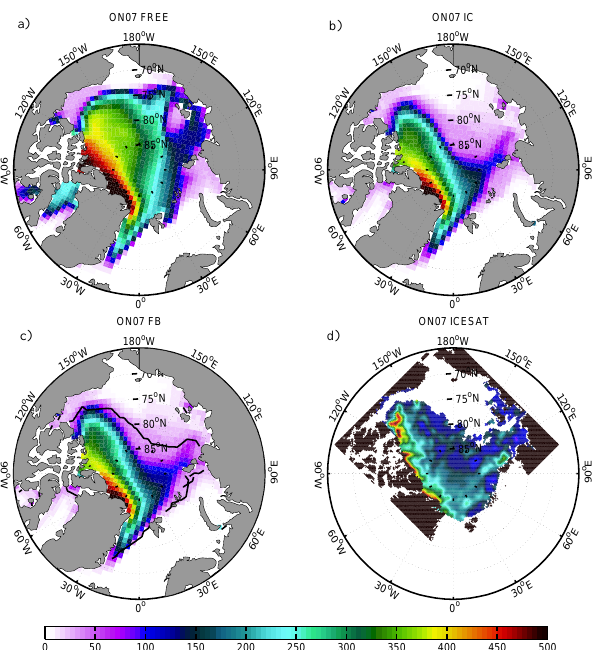
Fig. 8. Sea-ice thickness during the ON07 campaign in the FREE, IC and FB runs ( a, b, c respectively), and in the observations (Kwok et al., 2009). The black line corresponds to the sea-ice edge simu- lated in FB at the minimum extent (17 September 2007).